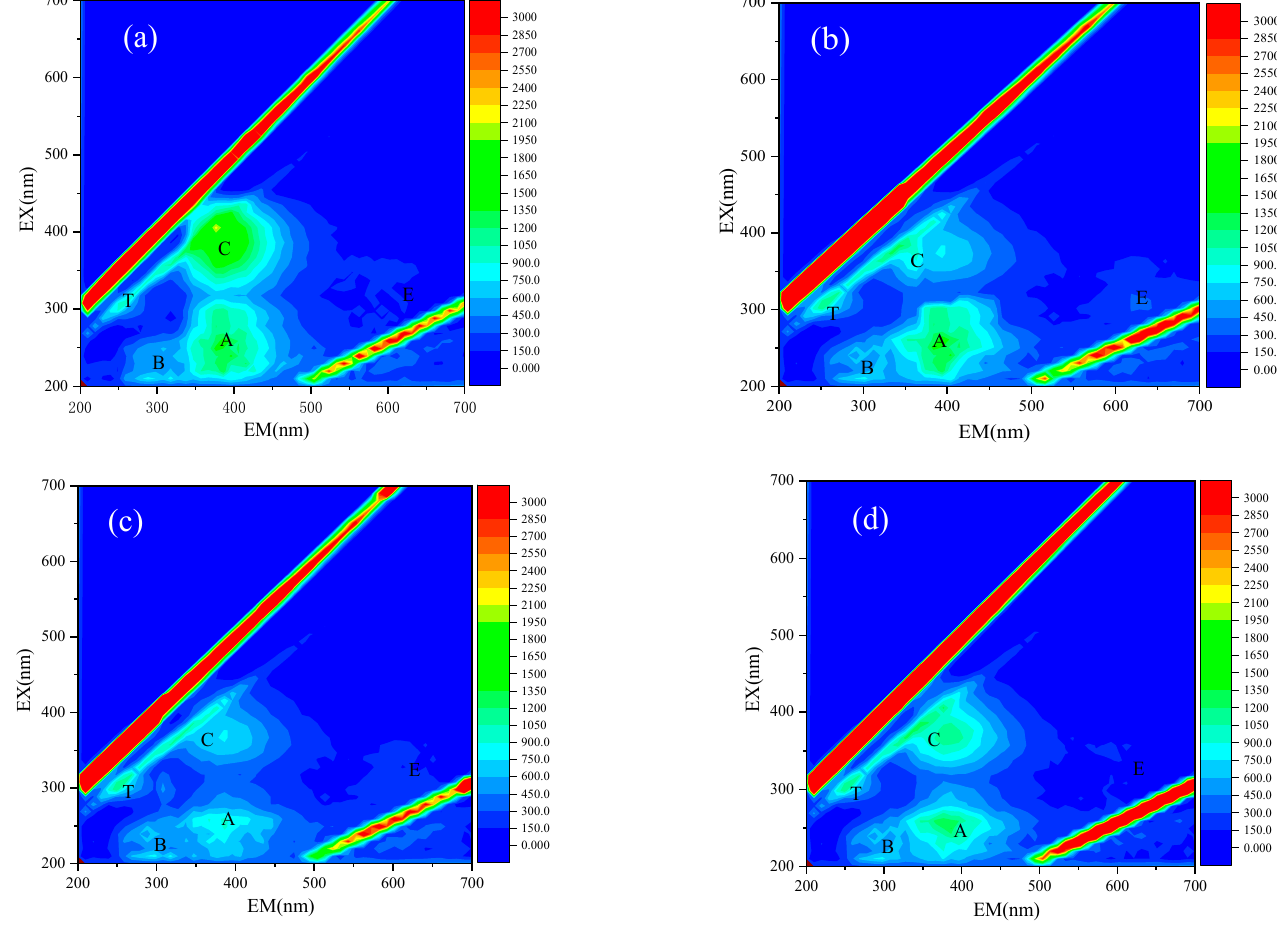
Figure 4. Fluorescence 3D-EEM for IOM after MC-LR adsorption in the presence of IOM in control ( a ), PE ( b ), PS ( c ), and PMMA ( d ).